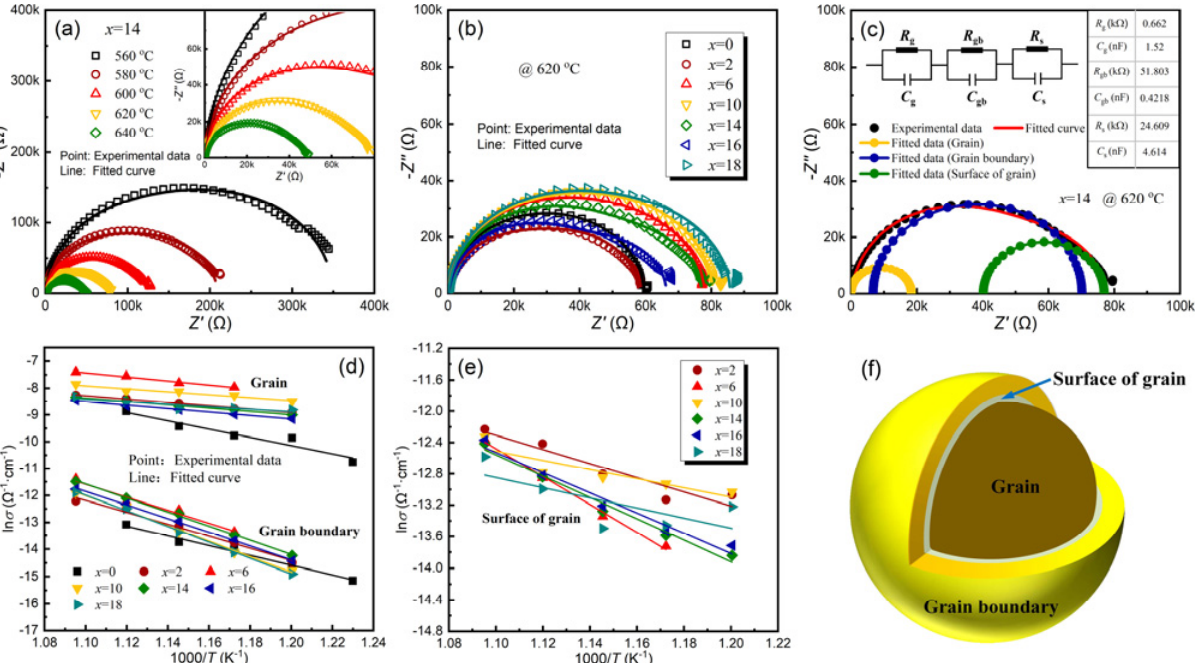
Fig. 8 (a) Complex impedance spectra of BS 0.5 BNT–14GS ceramic composite at different temperatures, (b) complex impedance spectra of BS 0.5 BNT– x GS ceramic composites at 620 ℃ , (c) complex impedance spectra and fitting curve of BS 0.5 BNT–14GS ceramic composite at 620 ℃ , (d) fitted pattern of ln σ to 1000/ T for grain and grain boundary, (e) fitted pattern of ln σ to 1000/ T for surface of grain, and (f) illustration of core–shell structure of ceramic